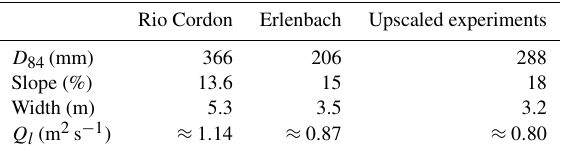
Table 2. Main characteristics of the Rio Cordon and Erlenbach rivers considered to scale the experimental conditions. The values of liquid discharge for the reference channels refer to a recurrence interval of 5 years (Schneider et al., 2014). The upscaled experi- mental values are computed using λ =